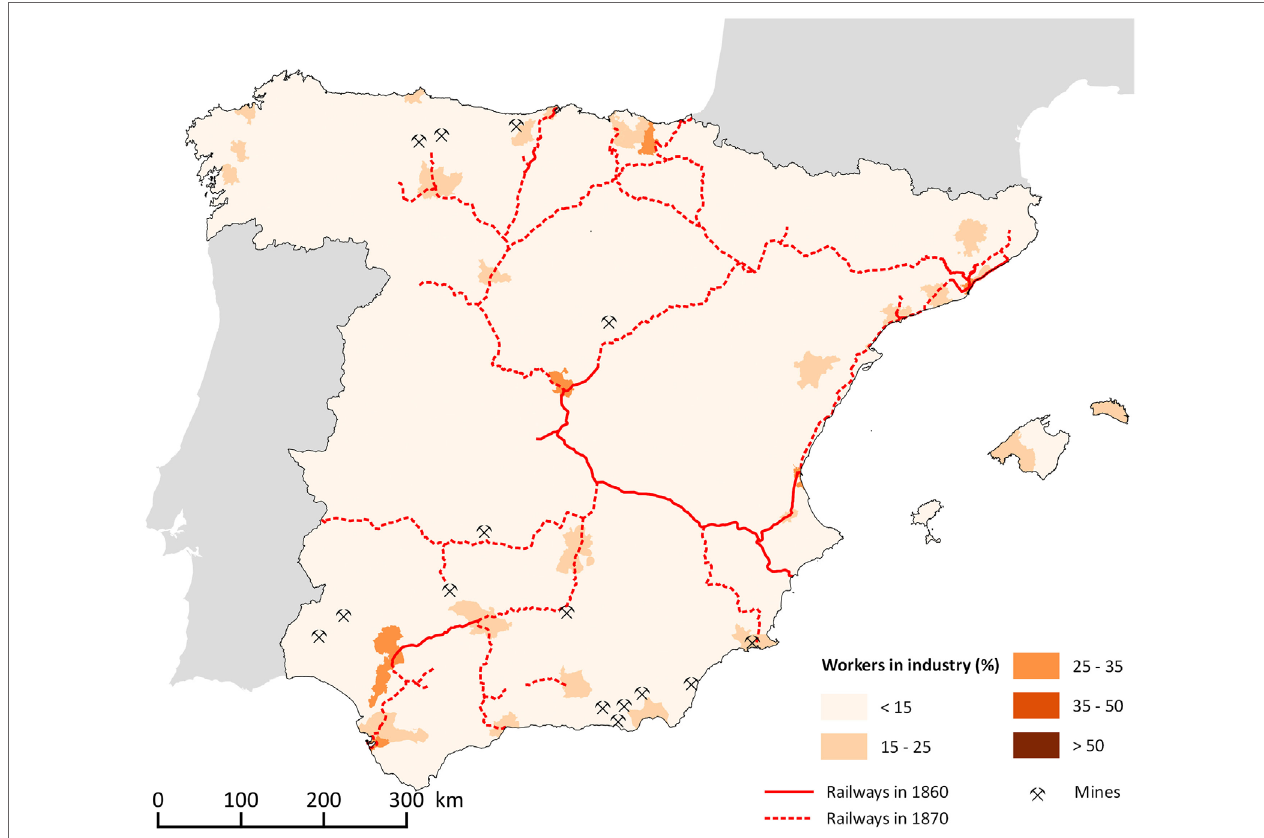
FigUre 5 | Percentage of industrial workers over the total occupied population in Spain in 1860, by judicial district. This figure does not include artisans. Source: Own